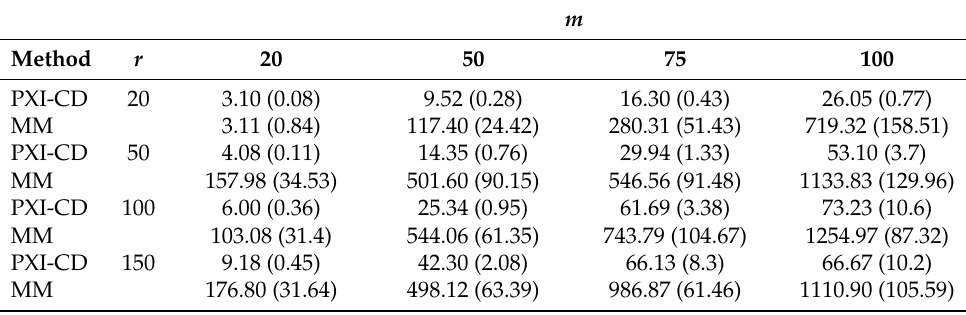
Table 2. The running times (s) when V i are low-rank, n = 1000, and γ 0 =